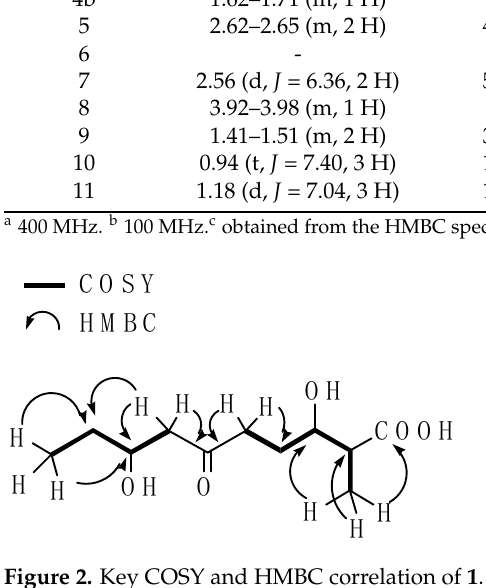
Table 2. 1 HNMR spectral data for 2 – 5 in CDCl 3.